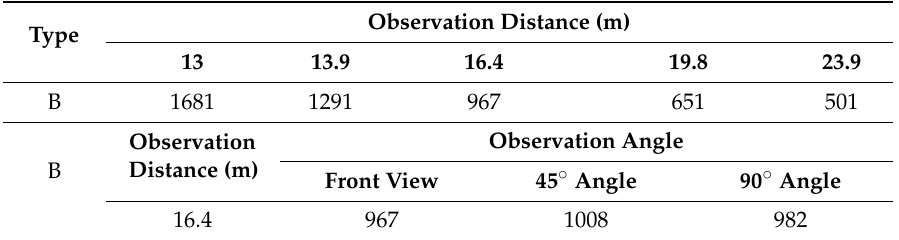
Table 8. Photon numbers of Type B in the on ‐ site test.